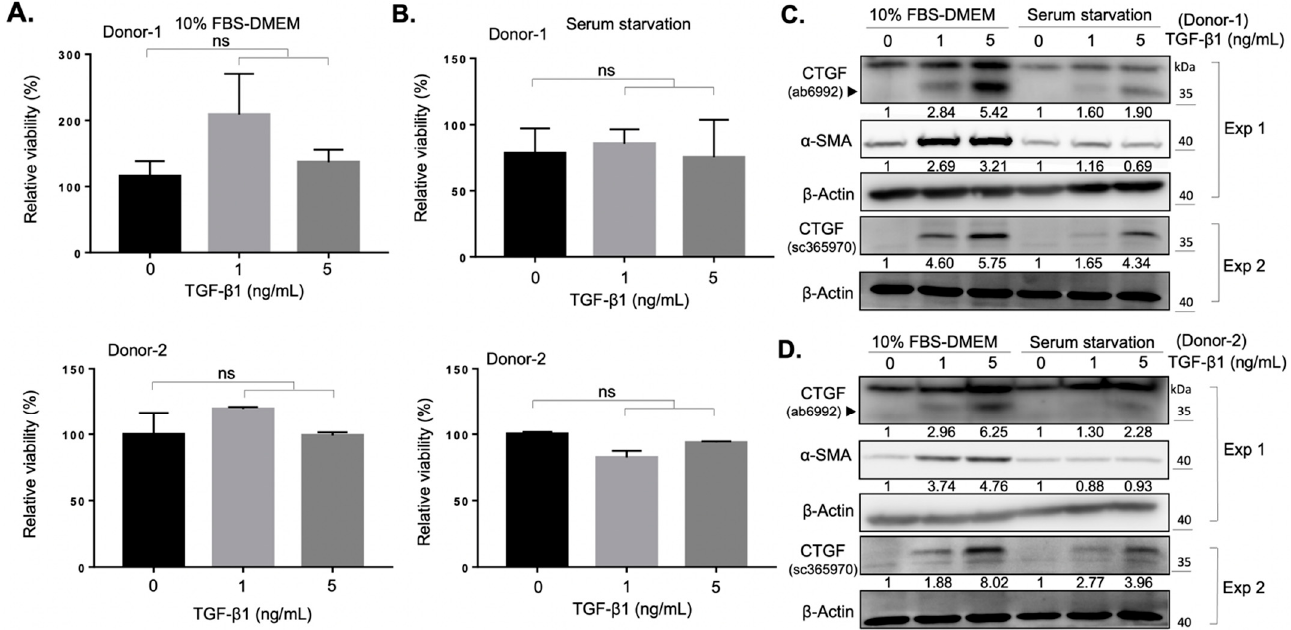
Figure 1. TGF- β 1 promotes the myofibroblast differentiation of orbital fibroblasts. ( A ) The viability of fibroblasts from a normal subject (Donor-1) and a GO patient (Donor-2) was measured after treatment with the indicated doses of TGF- β 1. Cells were seeded in 10% FBS-containing medium overnight and treated with TGF- β 1 for an additional 24 h. Data are expressed as the mean ± SD ( n = 3). ns, not significant. ( B ) Viability of the fibroblasts was measured after treatment with indicated doses of TGF- β 1. Cells were seeded in the basal DMEM medium overnight and treated with TGF- β 1 for an additional 24 h. Data are expressed as the mean ± SD ( n = 3). ns, not significant. ( C ) Western blots showed the expression of CTGF and α -SMA at indicated culture conditions of the orbital fibroblasts from Donor-1 for 24 h. The relative intensity value to corresponding controls was indicated below. Exp 1: experiment 1; Exp 2: experiment 2. ( D ) Western blots showed the expression of CTGF and α -SMA at indicated culture conditions of the orbital fibroblasts from Donor-2 for 24 h. The relative intensity value to corresponding controls was indicated below. Exp 1: experiment 1; Exp 2: experiment 2.